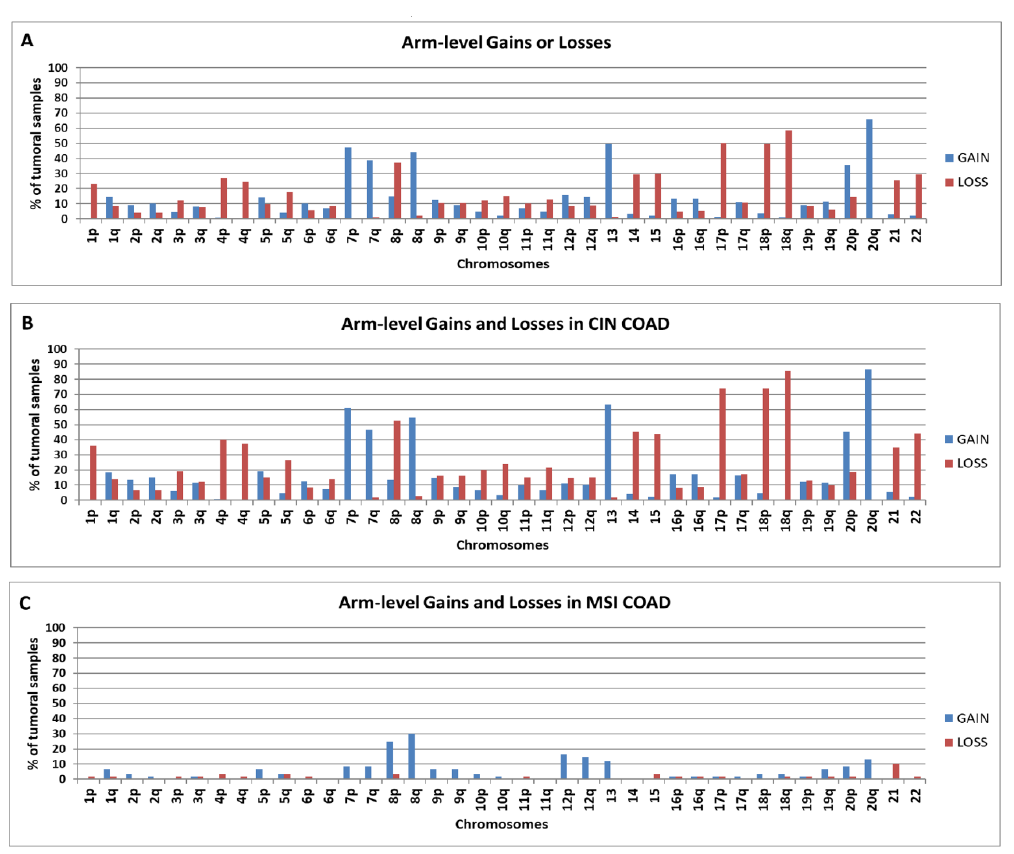
Figure 1. Results are expressed as the percentage of tumour samples bearing arm-level gains or losses in the p or q arm in all colon adenocarcinoma (COAD) samples ( A ), in Chromosomal INstability colon adenocarcinoma (CIN COAD) samples ( B ) or MicroSatellite Instability (MSI) COAD samples ( C ).